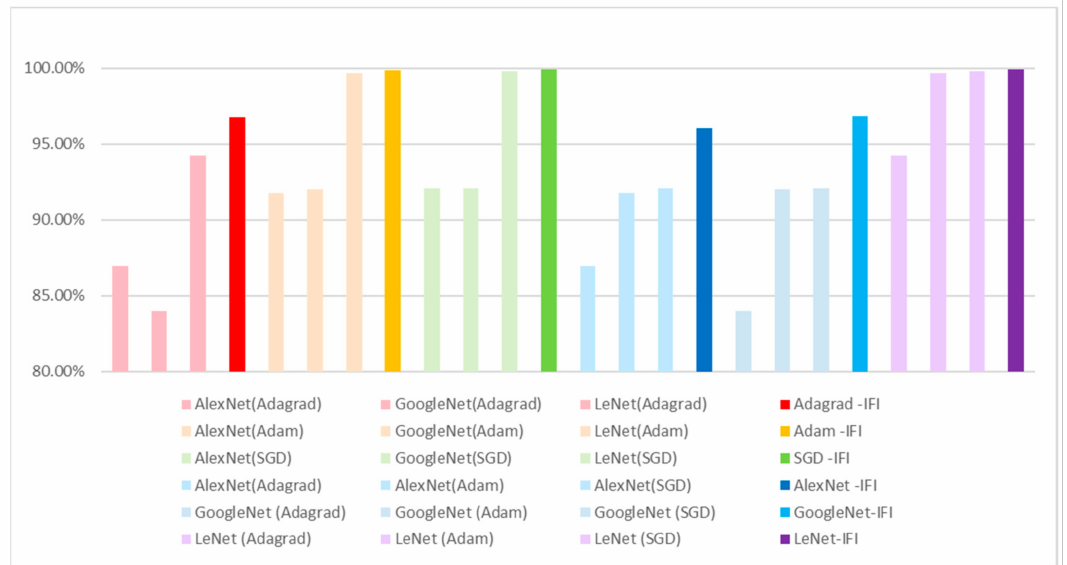
Figure 11. Recognition accuracy in di ff erent CNNs.